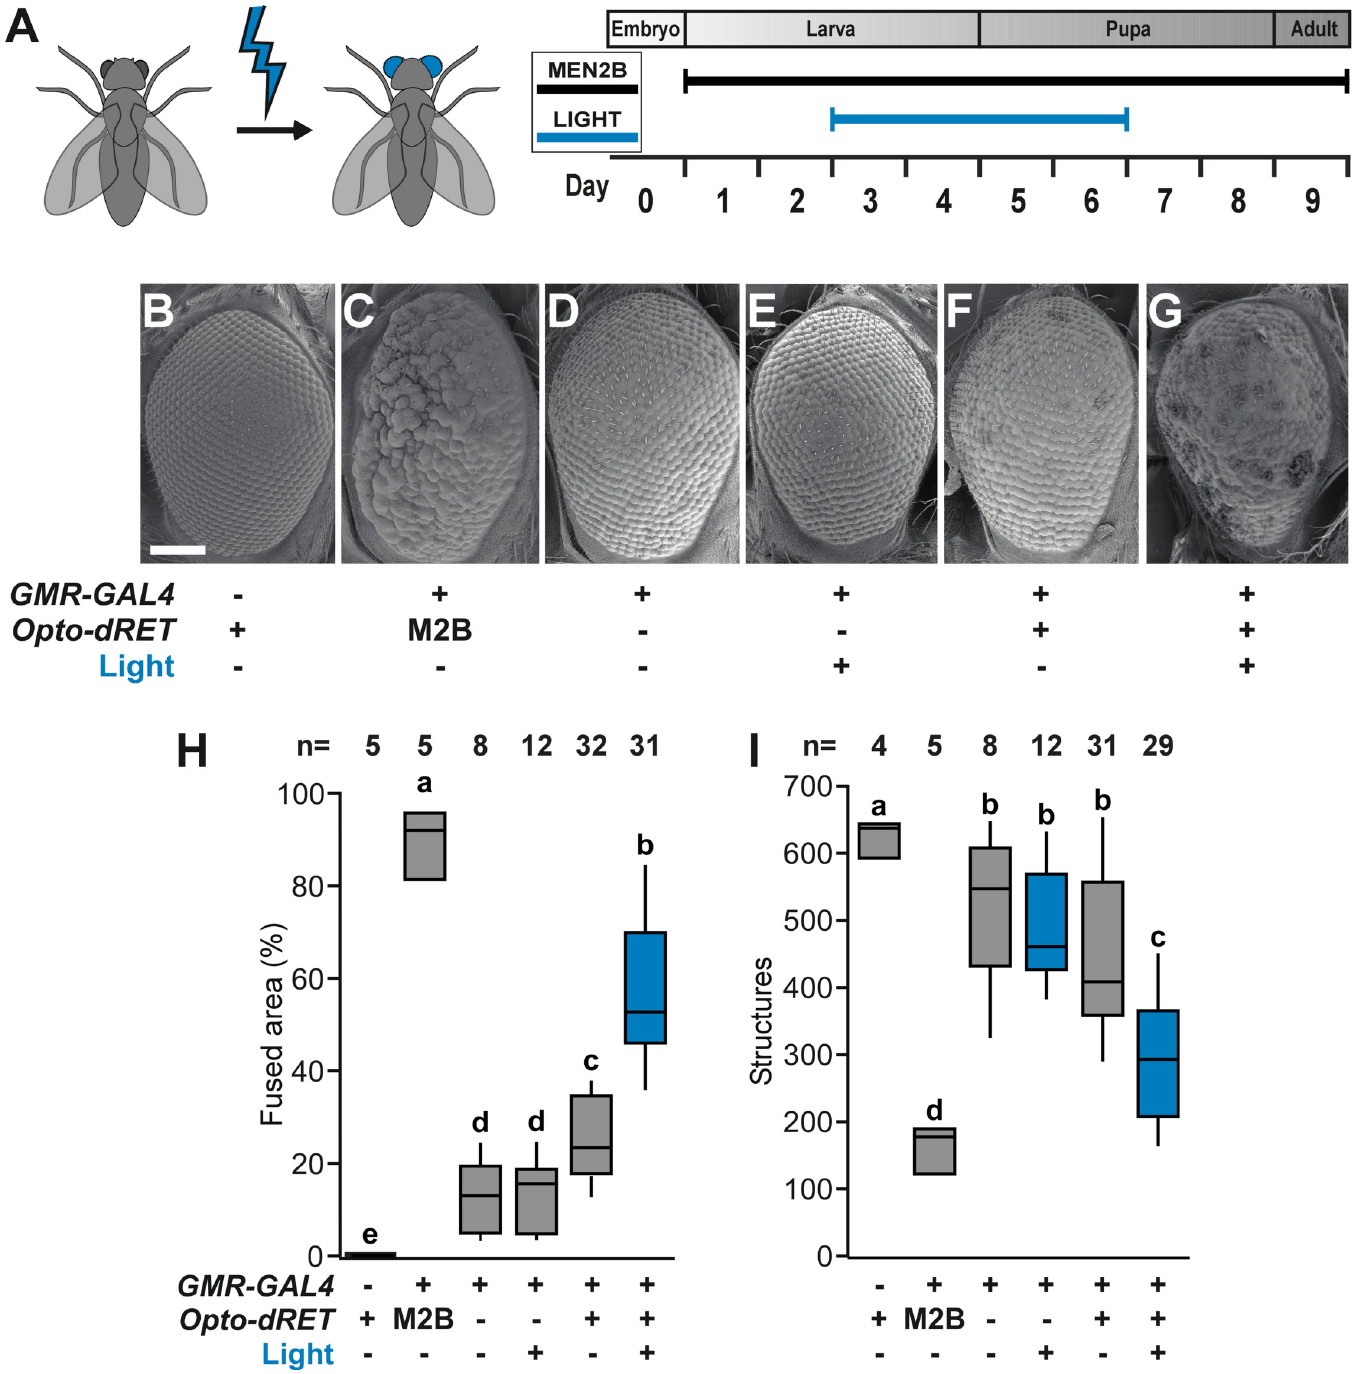
Fig 2. Induction of retina roughening and phenotype quantification. ( A ) Developmental time window targeted by light in retina experiments. ( B-G ) Representative retina SEM images. Scale bar: 0.1 mm. ( H and I ) Quantification of rough retina phenotypes of one-day old flies as fused area and the number of structures identified. “M2B” denotes Opto-dRET MEN2B . The number of analyzed flies is given (at least three independent experiments) and bars sharing the same label are not significantly different (ANOVA/Bonferroni corrected t-tests of means, p > .04). Continuous light intensity was 385 μ W/cm 2 for the duration shown in A.